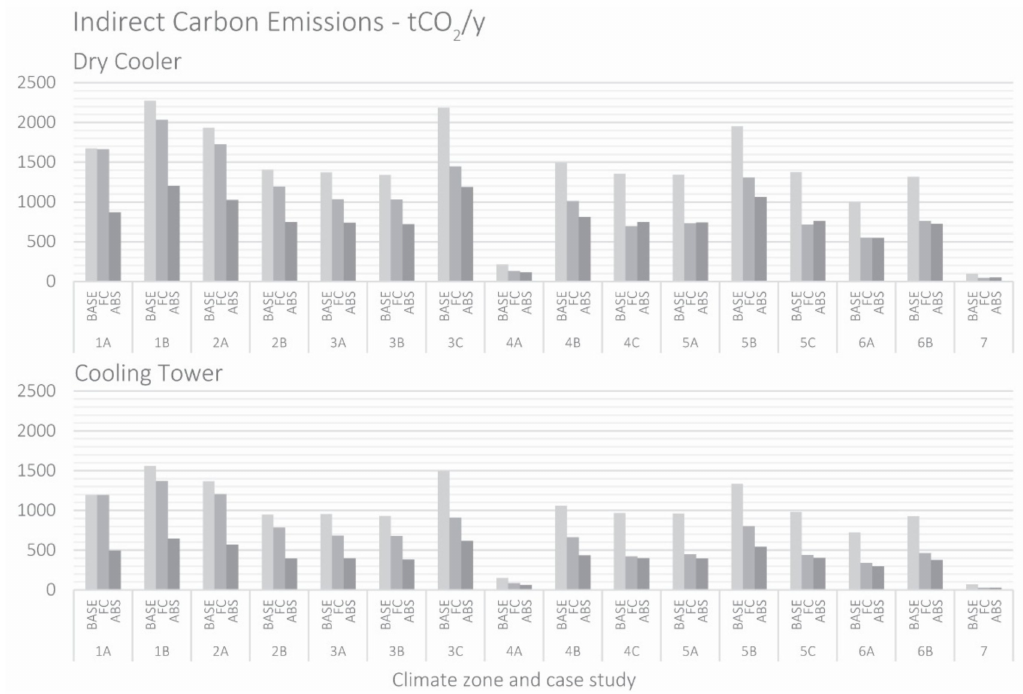
Figure 8. Indirect CO 2 emission based on climate zone and case study.